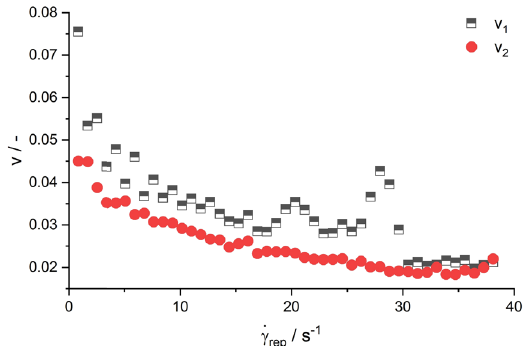
Figure 13: Values of the coe ffi cient of variation v vs the shear rate for the fi rst individual measurements ( v 1 ) and the second individual measurements ( v 2 ) with mean values of v 0.033 0.011 1 =